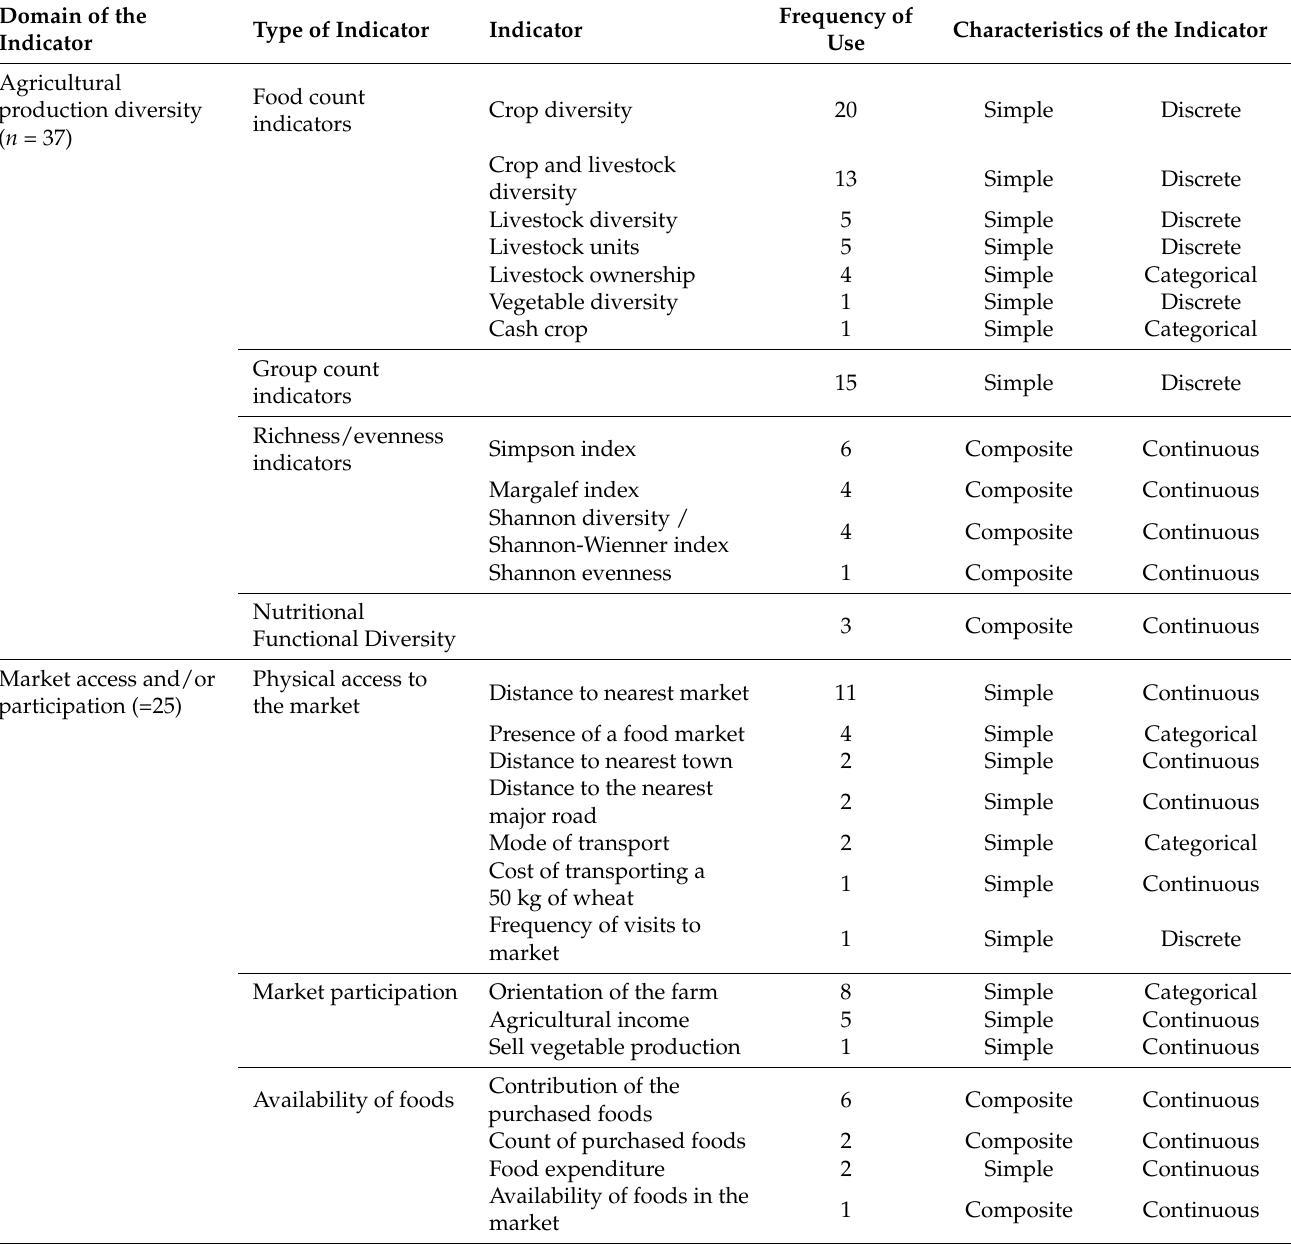
Table 1. Summary of the use of indicators of agricultural production diversity and of market access and/or participation. Domain of the